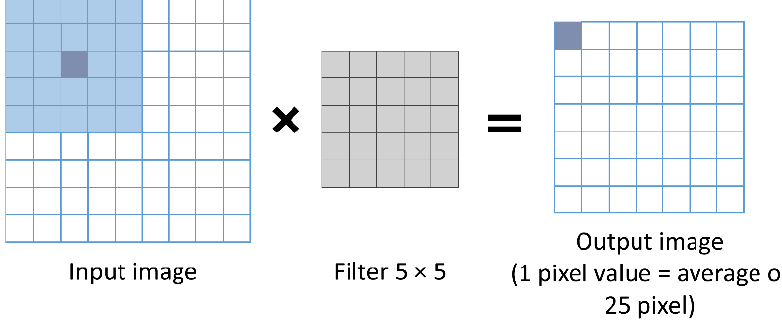
Figure 4. Illustration of smoothing filter application.